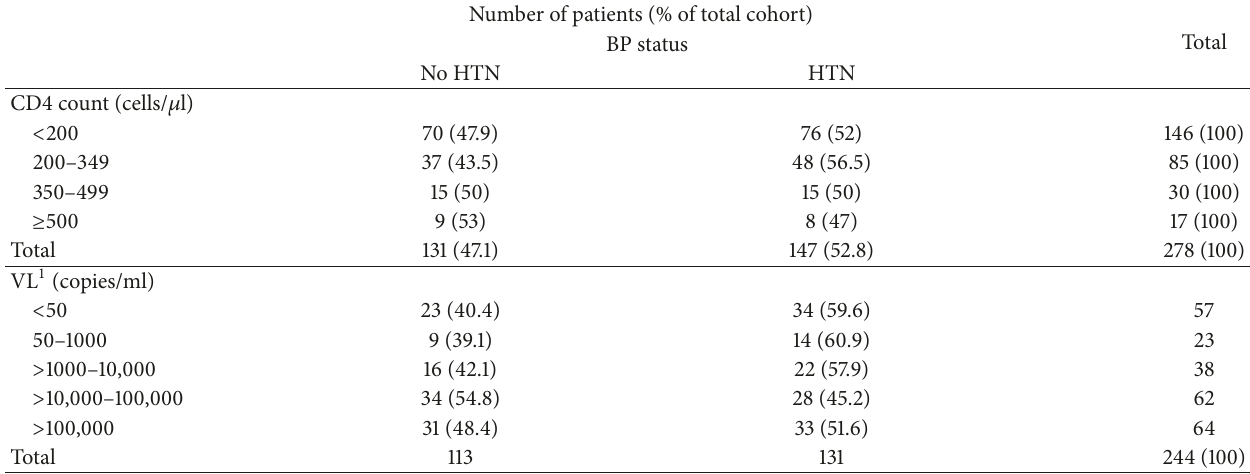
Table 2: Prevalence of HTN measured at the time of the lowest recorded CD4 count according to categorized CD4 and viral load levels ( 𝑃 > 0.05